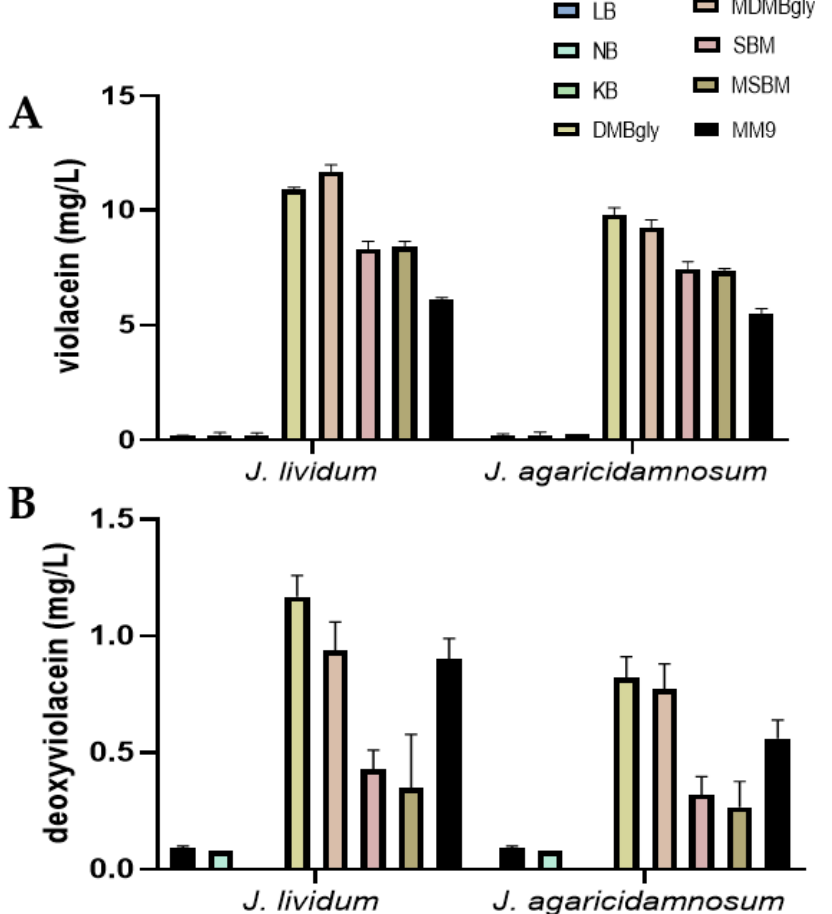
Figure 4. Violacein and deoxyviolacein production in Janthinobacterium following cultivation in different media. ( A ). Violacein production in J. agaricidamnosum DSM 9628 and J. lividum DSM 1552 across different culture media. ( B ). The production of deoxyviolacein in J. agaricidamnosum DSM 9628 and J. lividum DSM 1552 across different culture media. Violacein and deoxyviolacein were measured following 48 hours of fermentation in 5 L media, and the concentrations presented are the mean values of three independent replicates. Abbreviations: Luria–Bertani (LB), nutrient broth (NB), King’s B (KB), Davis minimal broth with glycerol (DMBgly), modified DMBgly (MDMBgly), shipworm basal medium (SBM), modified SBM (MSBM).